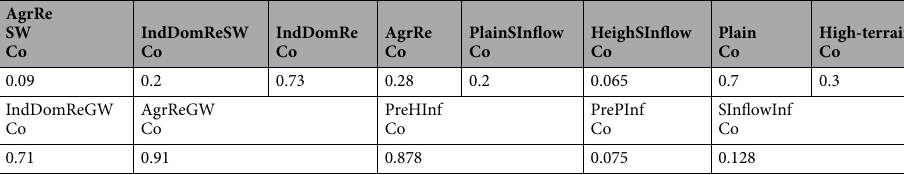
Table 6. Parameters obtained from